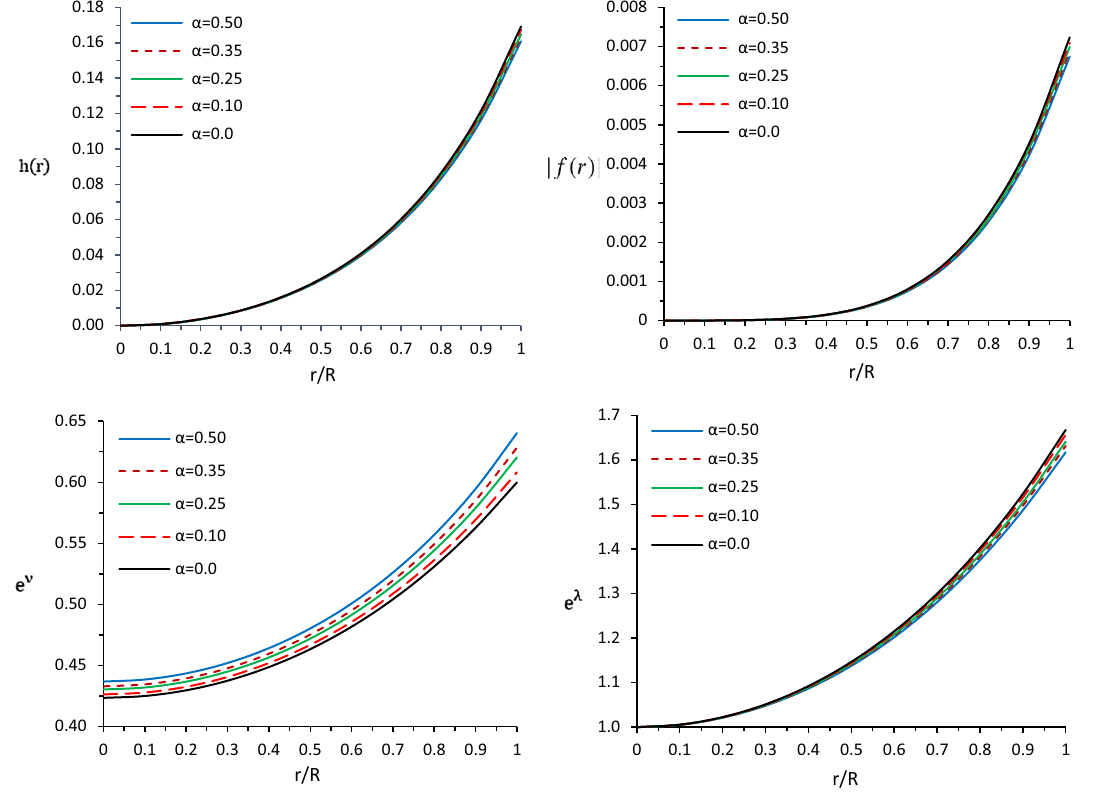
Fig. 2 The behavior of deformations functions h ( r ) (top left) and | f ( r ) | (top right) while the deformed metric potentials e ν( r ) (bottom left) and e λ( r ) (bottom right) verses radial coordinate r / R . For plotting of this figure we have taken the mass-radius ratio M / R = 0 . 2